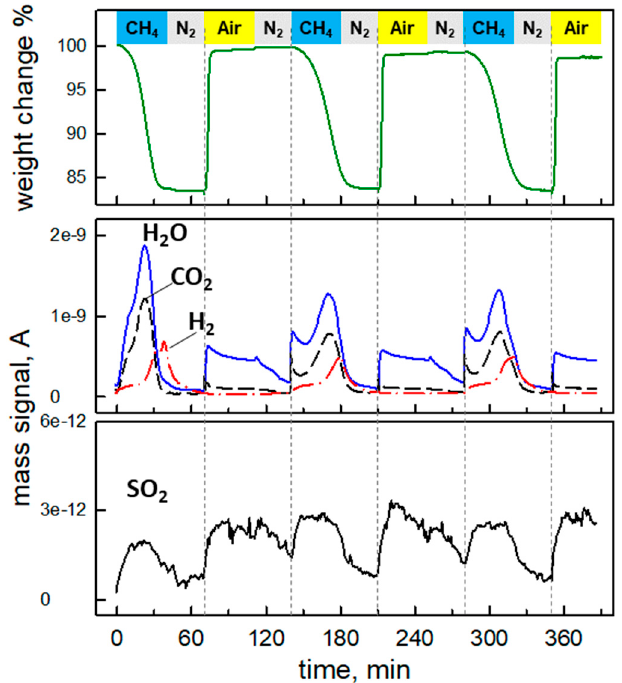
Figure 9. Weight change and gas concentration profiles during chemical looping reactions under feed stream of 5% CH 4 /N 2 and air at 800 ◦ C over Co-La 2 O 2 SO 4 cycled feed stream of 5% CH 4 /N 2 and air at 800 °C over Co-La 2 O 2 SO 4 .